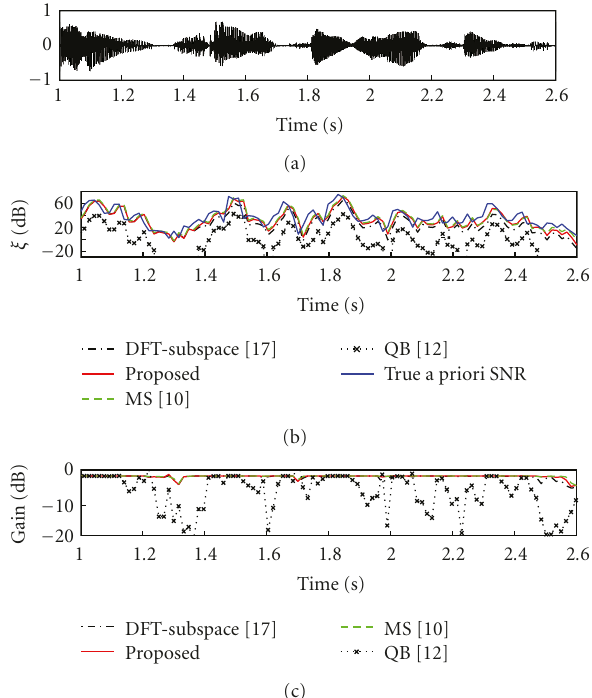
Figure 9: (a) Clean speech signal. (b) Comparison at frequency bin centered around at 1.25 kHz between the estimated a priori SNR and the true a priori for speech degraded by white noise at an SNR of 60dB. (c) The amount of suppression that is applied using estimated a priori SNR for speech degraded by white noise at an SNR of 60